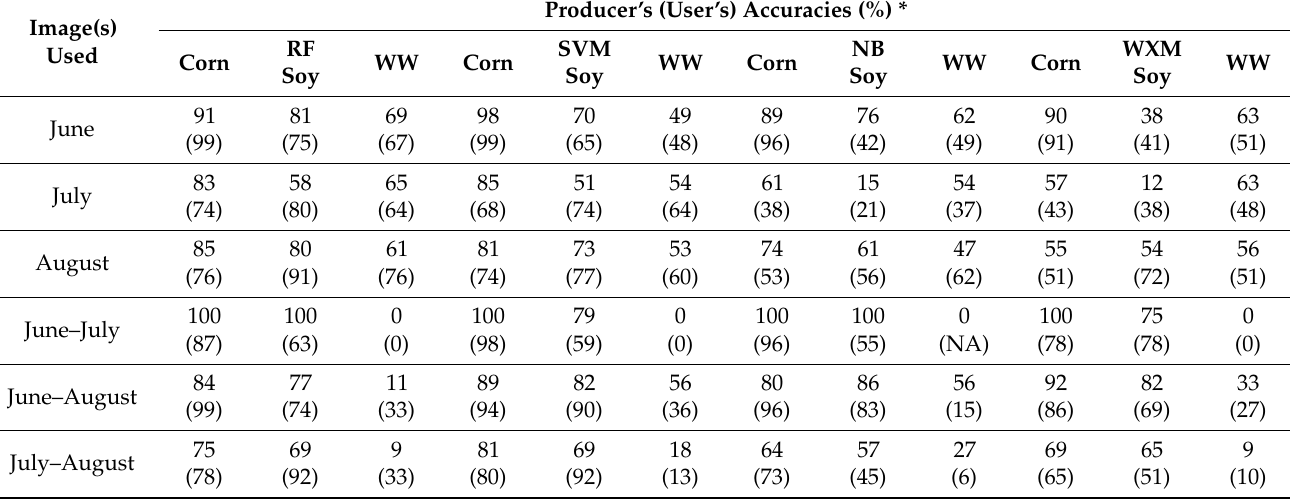
Table 11. DESIS Producer’s and User’s Accuracies. Producer’s and user’s classification accuracies for three leading world crops (corn, soybean, and winter wheat) from four classification algorithms (Random Forest—RF, Support Vector Machine—SVM, Naive Bayes—NB, and WekaXMeans—WXM) using 29 DESIS hyperspectral narrowbands. Analysis was conducted for June through August, 2019. Soy = Soybean, WW = Winter Wheat. Image(s)